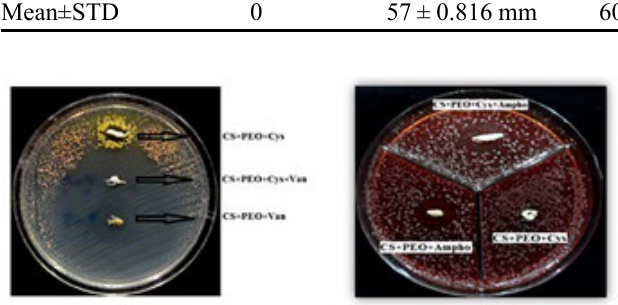
TABLE III - The diameter of the zone inhabitation surrounding the fibers NO.